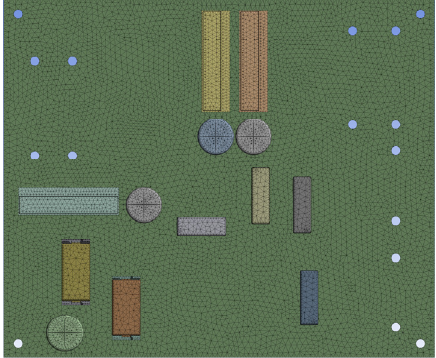
Figure 10. PCB simplified